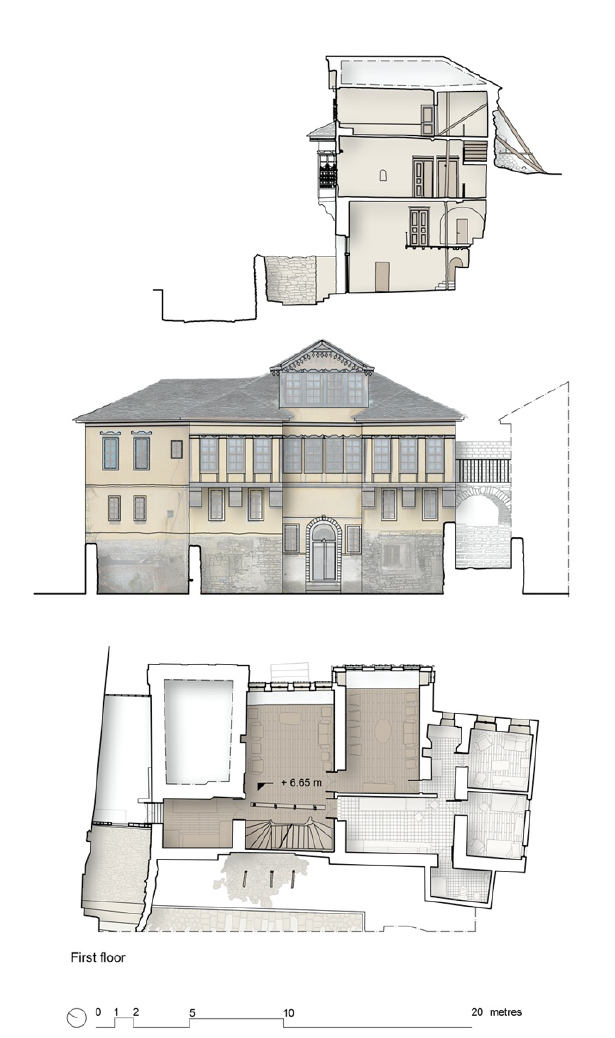
Figure 5. Plan, main façade and cross sections of Fico house (Survey: E. Barhi, F. Bregaji, J. Demiraj, G. Koli, J. Myftaraj. Graphic editing: E.